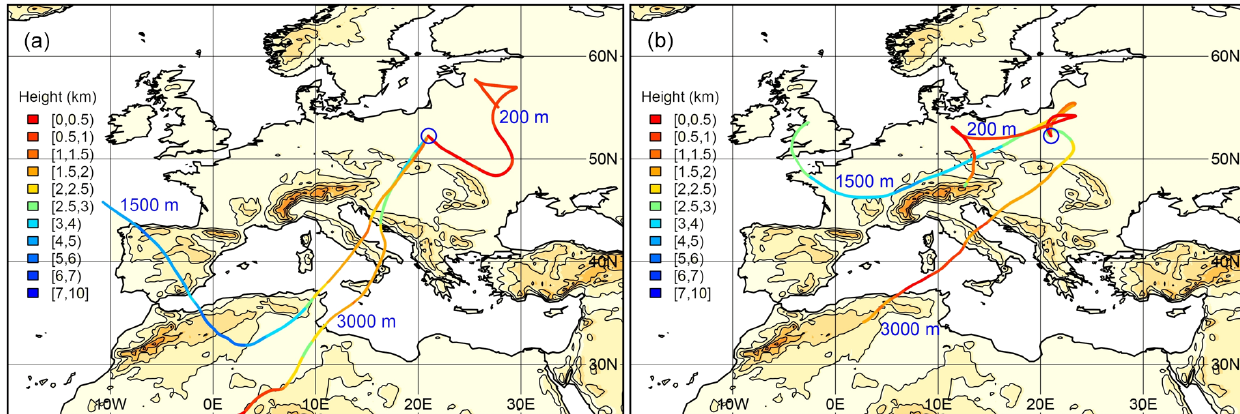
Figure 8. Air mass trajectories arriving to Warsaw at 200, 1500, and 3000ma.s.l. at 08:00 on 18 February (a) and at 12:00 on 8 March (b) . The colors along a trajectory indicate the height of the air parcels.